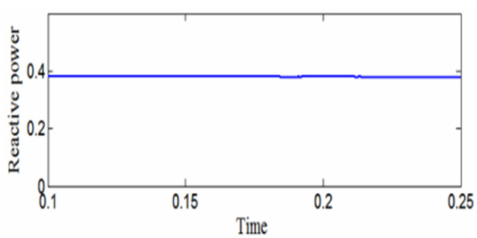
Figure 39. Reactive power demand from the load side.